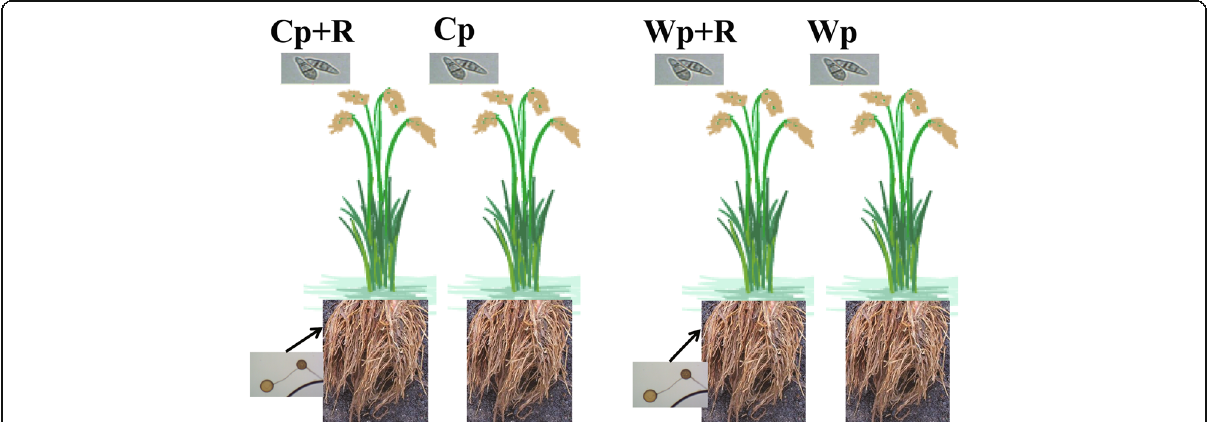
Fig. 1 The four experimental treatment groups designed to comparatively study the responses of wild and cultivated rice plants to Magnaporthe oryzae infection with and without inoculation with the arbuscular mycorrhizal fungus Rhizoglomus intraradices . Cp + R, R. intraradices -inoculated cultivated rice infected with M. oryzae ; Cp, R. intraradices -uninoculated cultivated rice infected with M. oryzae ; Wp + R, R. intraradices -inoculated wild rice infected with M. oryzae ; Wp, R. intraradices -uninoculated wild rice infected with M.